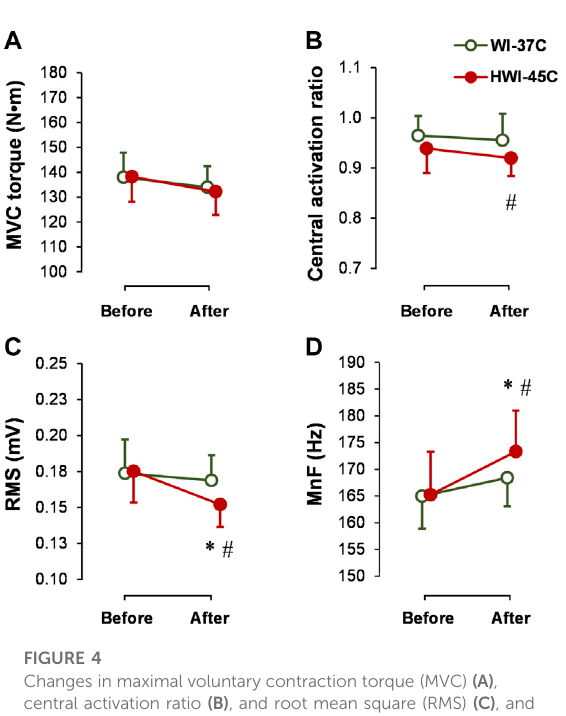
FIGURE 5 Changes in electrically induced ankle plantar fl exion muscle isometric peak torque at 1 Hz (P1), 20 Hz (P20), and 25 stimuli at 100 Hz (TT100) (A) , and TT100-induced muscle contraction plus half-relaxation time (CT + HRT) (B) and peak rate of torque development (RTD) (C) before and after whole-body immersion in water temperatures of 37 ° C (WI-37 ° C) and 45 ° C (HWI-45 ° C). * p < 0.05, HWI-45 ° C compared with before; # p < 0.05, HWI-45 ° C compared with WI-37 ° C. The p values relate to the time effect in WI-37 ° C. Values are expressed as mean and